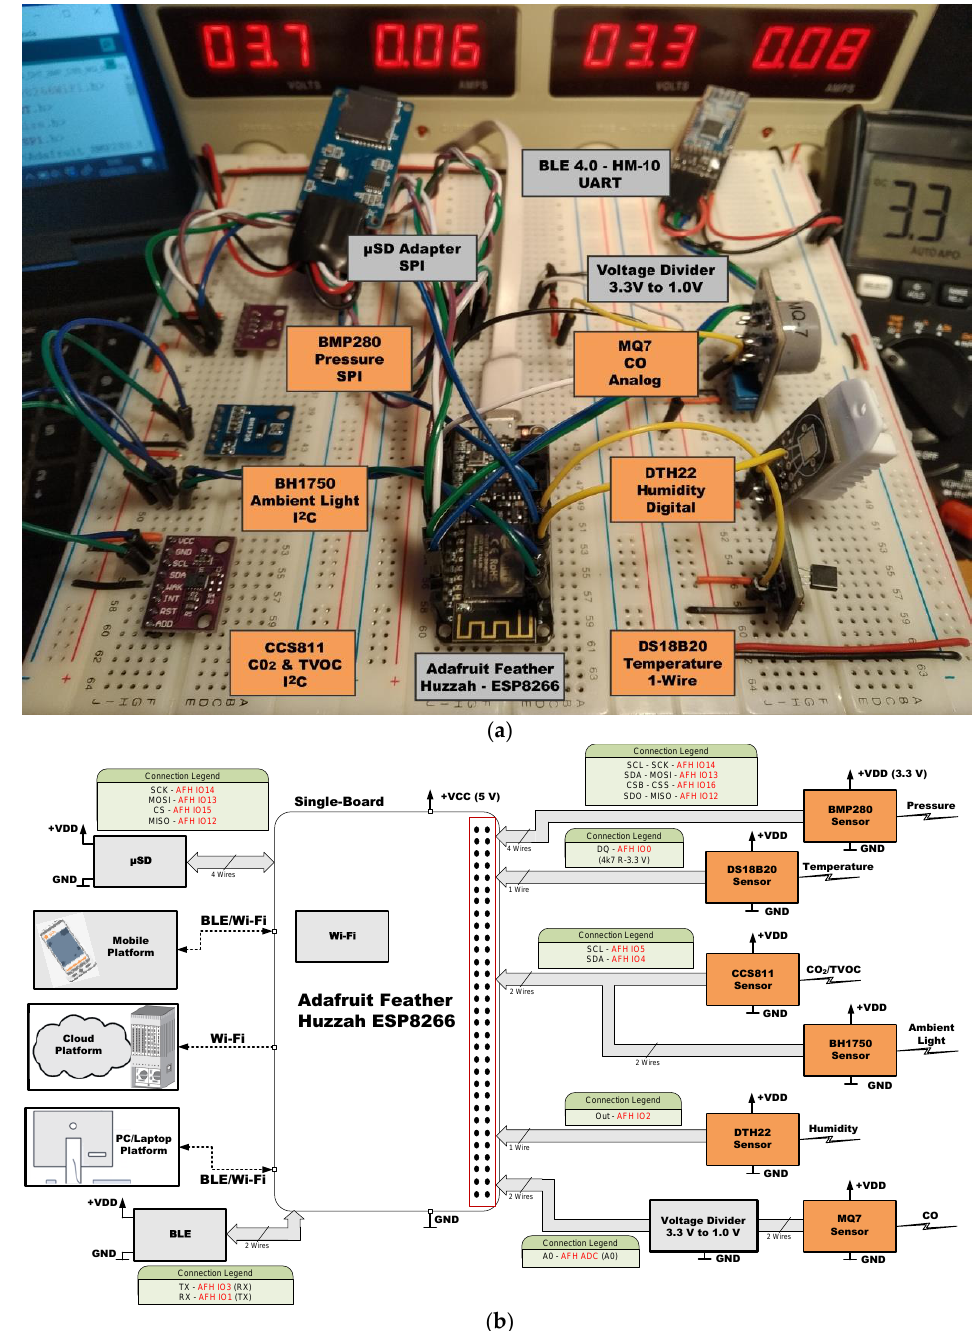
Figure 8. SBM Adafruit Feather Huzzah ESP8266 in experimental framework ( a ) and hardware connections ( b ) [150].